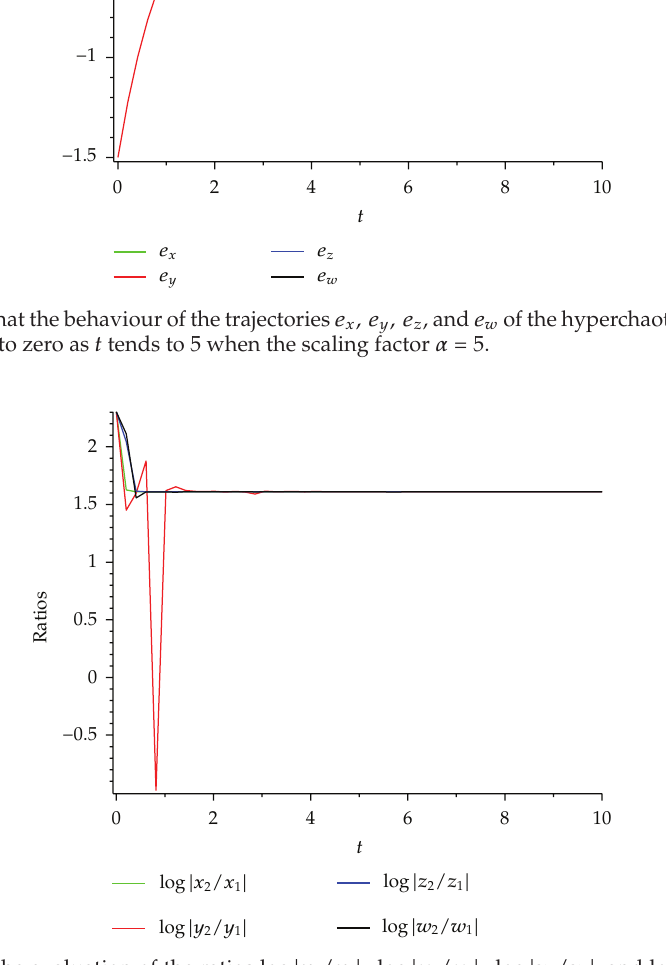
Figure 6: It shows the evaluation of the ratios log | x 2 /x 1 | , log | y 2 /y 1 | , log | z 2 /z 1 | , and log | w 2 /w 1 | whose limits are equal to to log5 (cid:8) 1 .